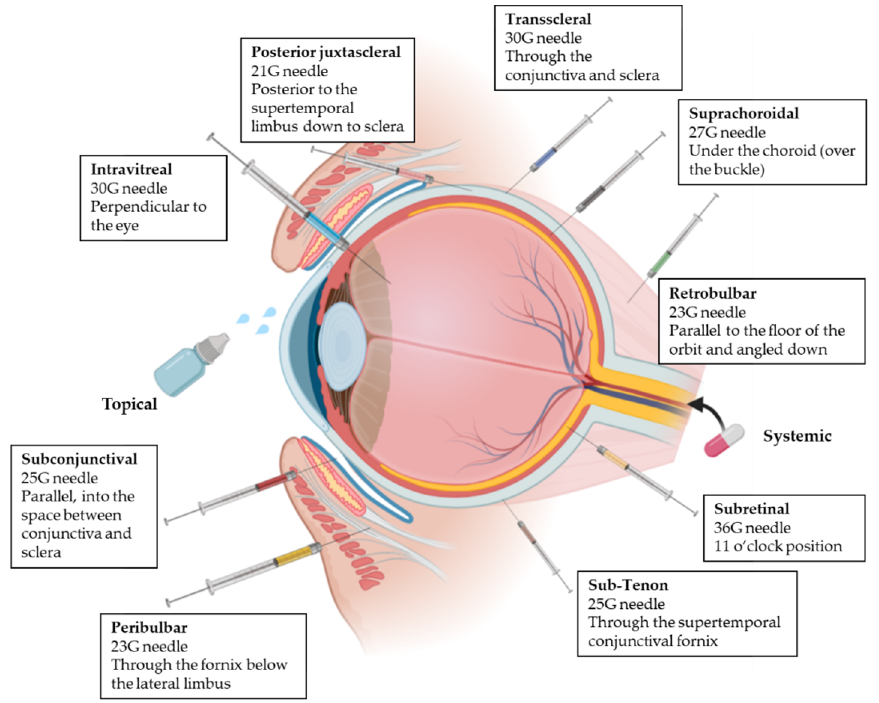
Figure 3. Representation of the different delivery routes for ocular administration [31,32]. Next to each administration, needle and injection technique are summarized. Adapted from